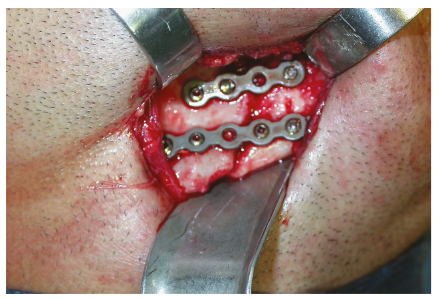
Figure 3: Rigid fi xing with titanium plates and screws.